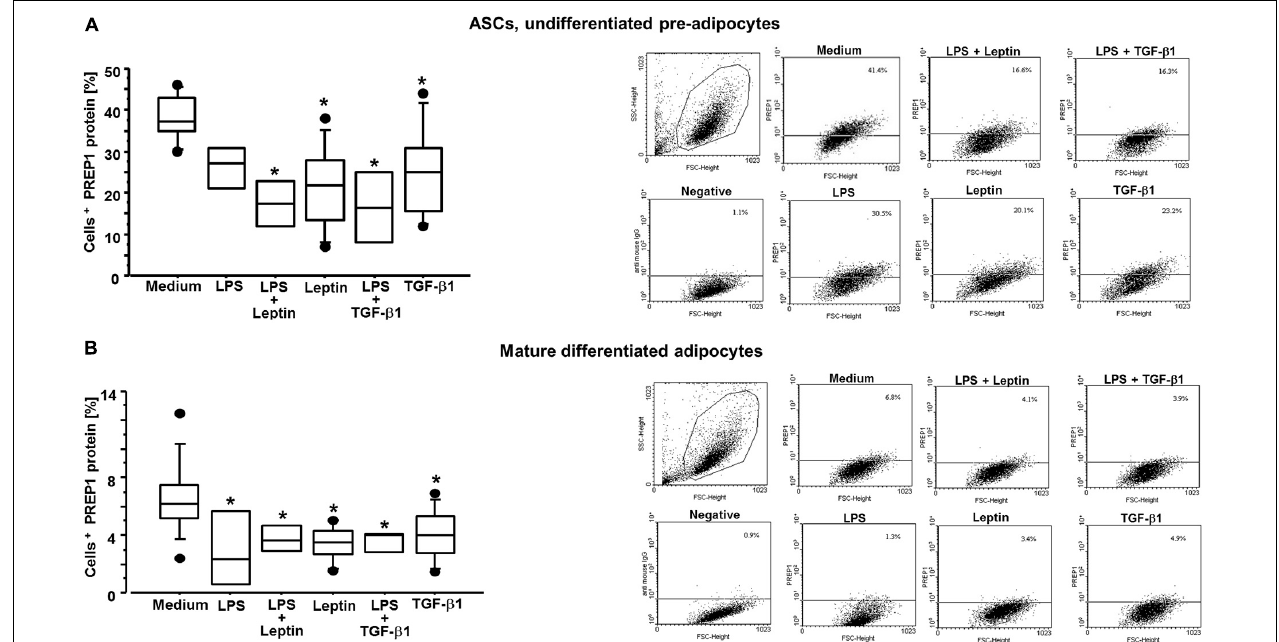
FIGURE 6 | (A) Flow cytometry analysis on ASCs for PREP1 with and without LPS for TLR4 activation: both leptin (0.05 µ M) and TGF- β 1 (400 nM) significantly reduced PREP1 expression with or without LPS (10 µ g/mL); medium vs. leptin + LPS ( p = 0.0135); medium vs. leptin ( p = 0.0034); medium vs. TGF- β 1 + LPS ( p = 0.0100); medium vs. TGF- β 1 ( p = 0.0168); the results are shown as box-plots with medians (lines inside the boxes), 25th and 75th percentiles (limits of boxes), and the 10th and 90th percentiles (whiskers), at least n = 3 experiments. Analysis of variance (ANOVA), Fisher’s PLSD. Right, representative examples of flow cytometric analysis. The numbers indicate the percentage of positive cells for PREP1. (B) Flow cytometry analysis on mature differentiated adipocytes for PREP1 with and without LPS for TLR4 activation: both leptin (0.05 µ M) and TGF- β 1 (400 nM) significantly reduced PREP1 expression with or without LPS (10 µ g/mL); medium vs. LPS ( p = 0.0136); medium vs. leptin + LPS ( p = 0.0484); medium vs. leptin ( p = 0.0032); medium vs. TGF- β 1 + LPS ( p = 0.0319); medium vs. TGF- β 1 ( p = 0.0116); the results are shown as box-plots with medians (lines inside the boxes), 25th and 75th percentiles (limits of boxes), and the 10th and 90th percentiles (whiskers), at least n = 3 experiments. Analysis of variance (ANOVA), Fisher’s PLSD. Right, representative examples of flow cytometric analysis. The numbers indicate the percentage of positive cells for